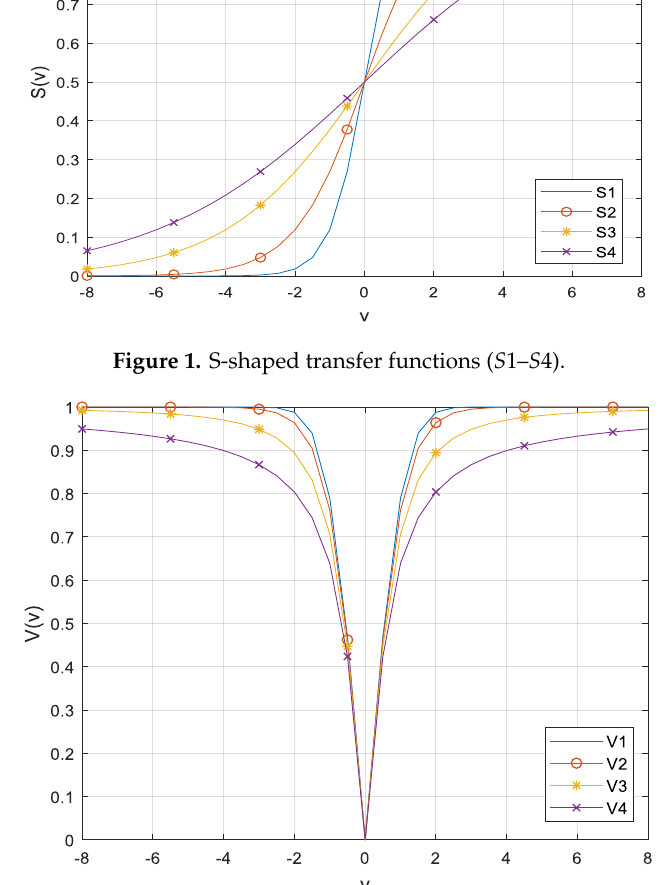
Figure 2. V-shaped transfer functions ( V1 – V4 ).